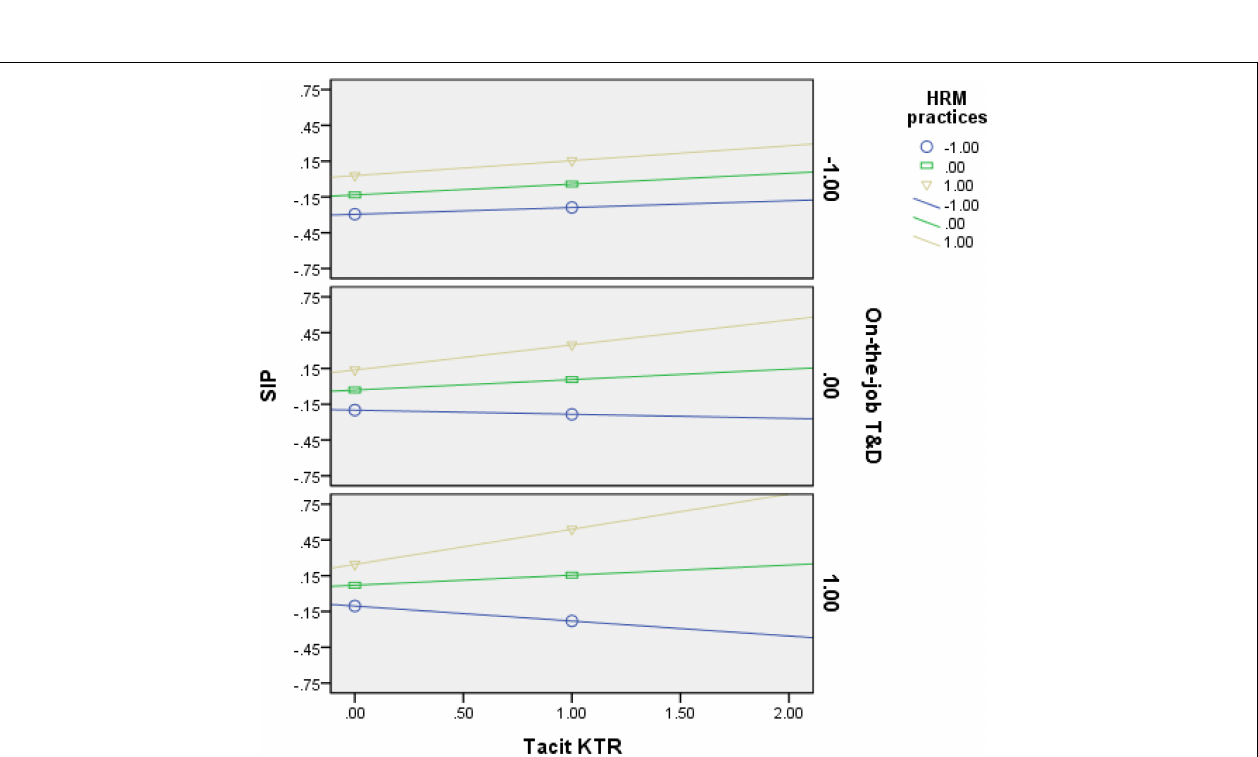
FIGURE 4 | The moderated moderation effects of on-the-job T&D on HRM practices, tacit KTR and SIP.